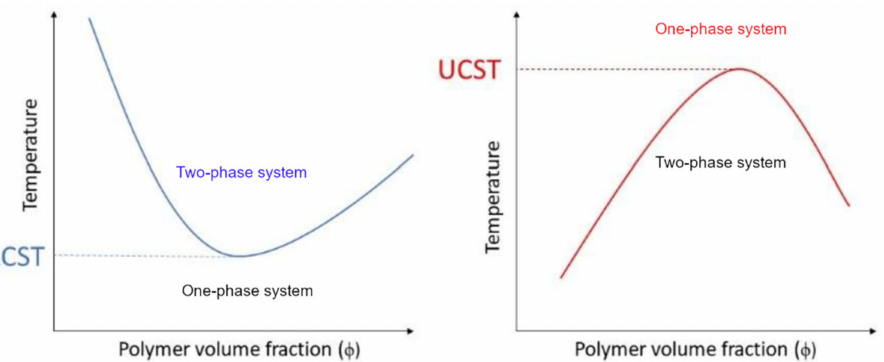
Figure 3. Temperature vs. polymer volume fraction ( φ ). Schematic illustration of phase diagrams for the polymer solution’s lower critical solution temperature (LCST) ( left ) and upper critical solution temperature (UCST) ( right